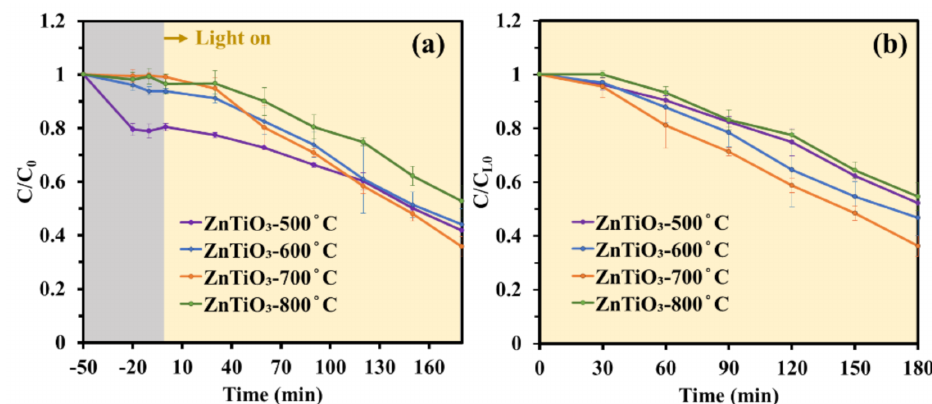
Figure 7. The changes of ( a ) C/C 0 and ( b ) C/C L0 for various ZnTiO 3 calcinated t 500~800 ◦ C with the reaction time to degrade